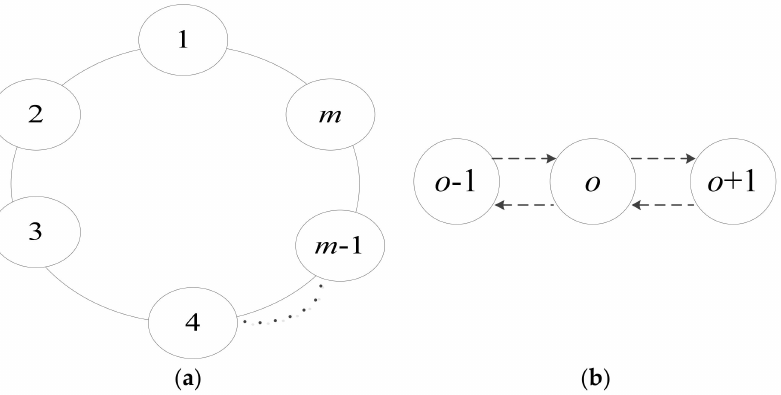
Figure 3. ( a ) A loop topology structure of elementary membranes in CQPSO-ETP; ( b ) the communi- cation relationship between elementary membrane and its neighboring